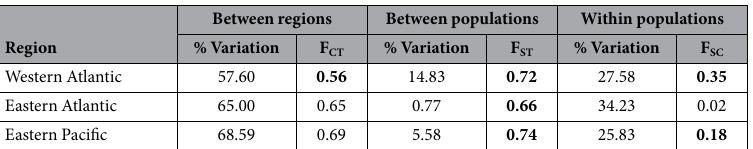
Table 1. Analysis of Molecular Variance (AMOVA), comparing populations on either side of a barrier suspected on the basis of phylogeny (see text) in each of three regions where Petrolisthes armatus occurs. The comparison in the western Atlantic is between populations North and South of Florida (Florida populations were included in the North region), in the eastern Atlantic between Sierra Leone and three locations in the Gulf of Guinea, and in the eastern Pacific between North and South of Panamá (Panamá populations were included in the North region). Bold values indicate significant values on the basis of 10,000